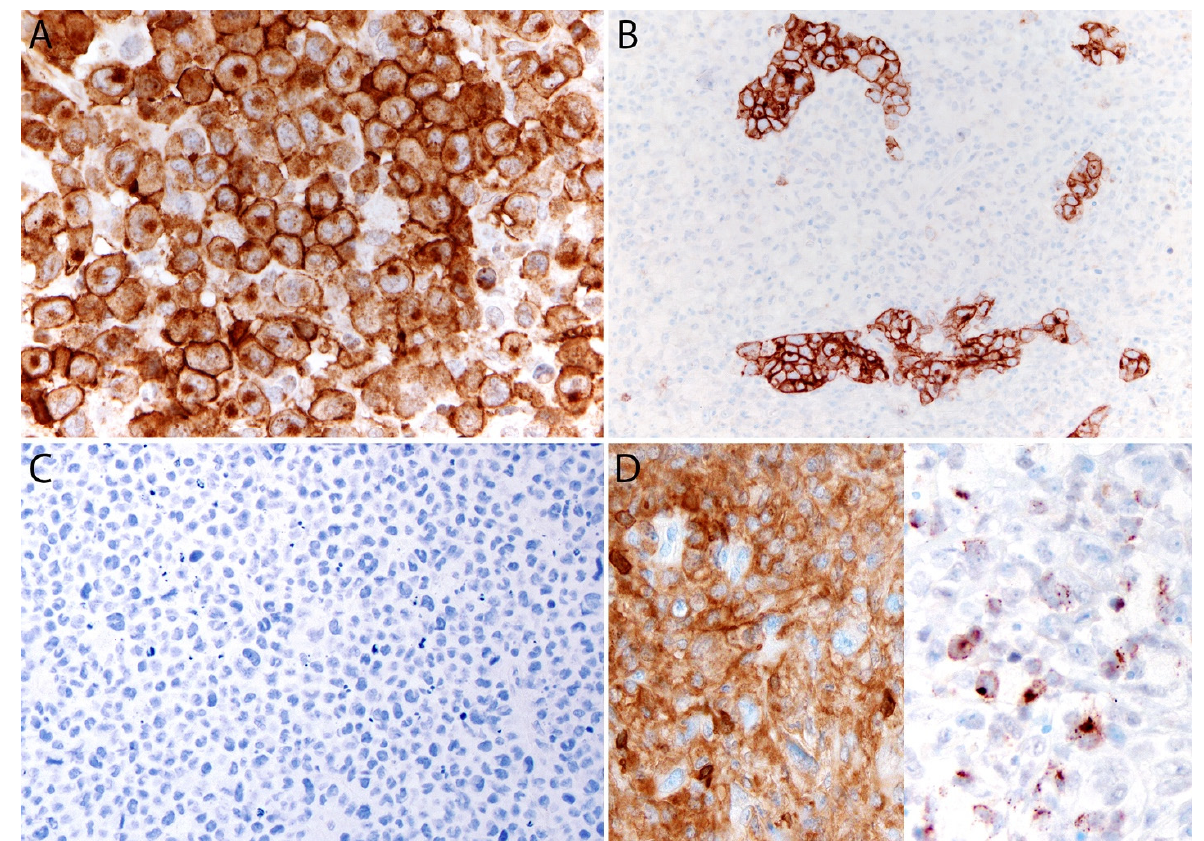
Figure 4. Immunohistochemistry in systemic ALK- ALCL. ( A ) CD30 (120 kDa glycoprotein) is strongly and diffusely positive in the tumor cells with a membranous and Golgi dot-like pattern. The Golgi labelling corresponds to the location of the CD30 protein precursor of 90 kDa. ( B ) CD30 highlights the sinusoidal distribution in a partially involved lymph node. ( C ) The ALK immunostain is negative. ( D ) Characteristic co-expression of CD4 (left) and cytotoxic markers, such as granzyme B (right).